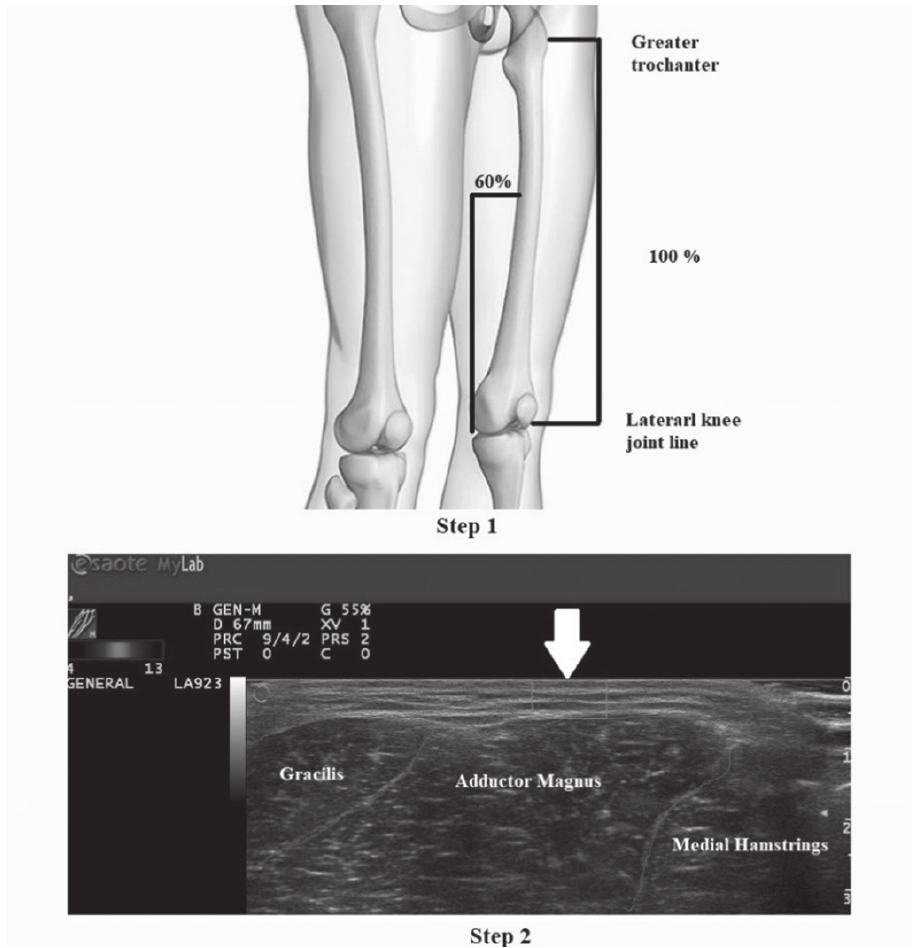
FIGURE 1. The process of adductor magnus (AM) location. Firstly, 60% of the femur length was used as a starting point to look for the AM using a probe of ultrasound on the medial aspect of the thigh (Step 1). Then, a clear definition of all muscle boundaries around AM (Step2). This followed by placing the EMG electrode centrally on the participant’s skin (white arrow).